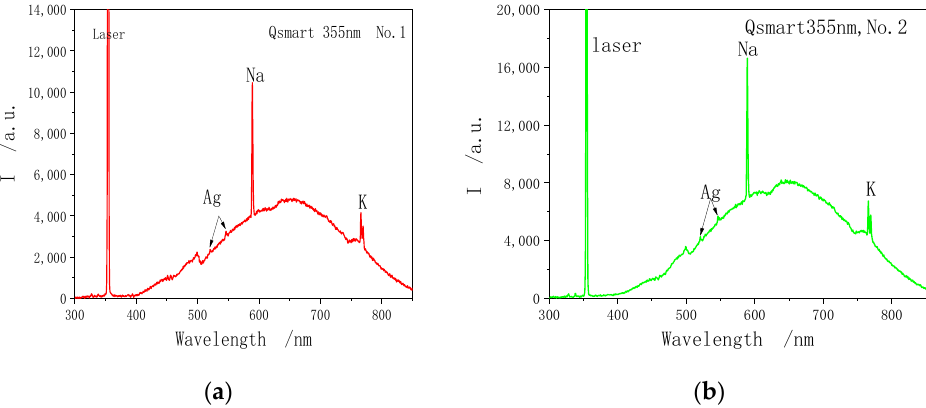
Figure 13. Experimental spectral data of SASN detonation by Q-Smart355 nm laser. ( a ) First experiment. ( b ) Second experiment.